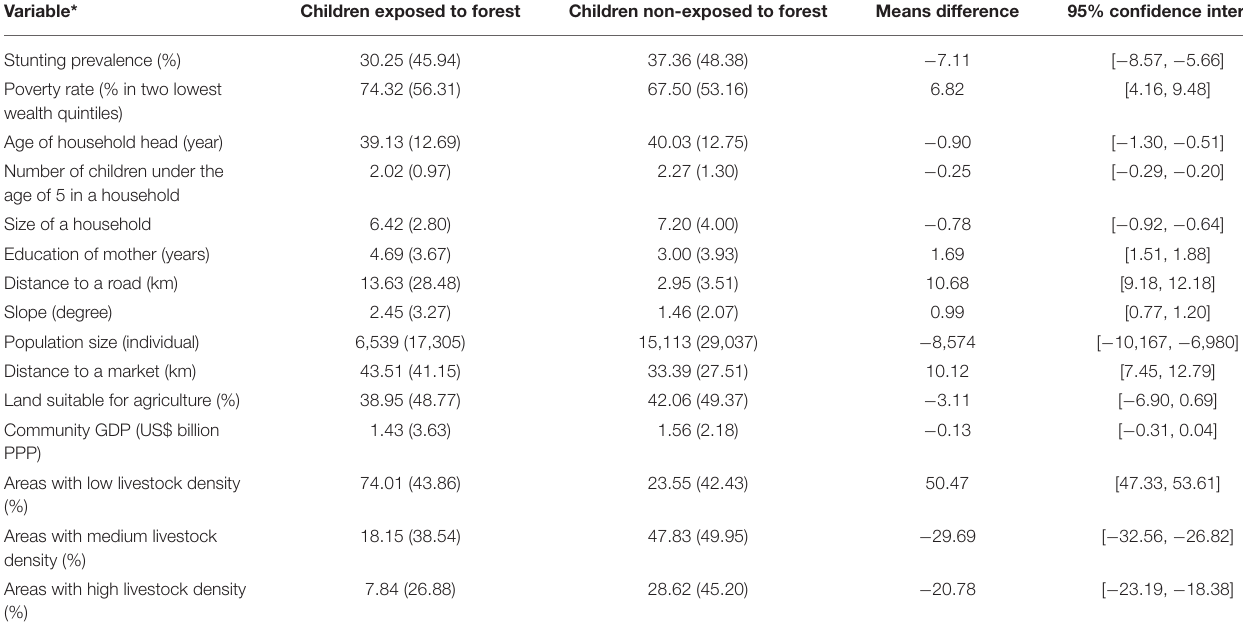
TABLE 1 | Means and standard deviations (in parentheses) of characteristics of children exposed vs. non-exposed to forest.